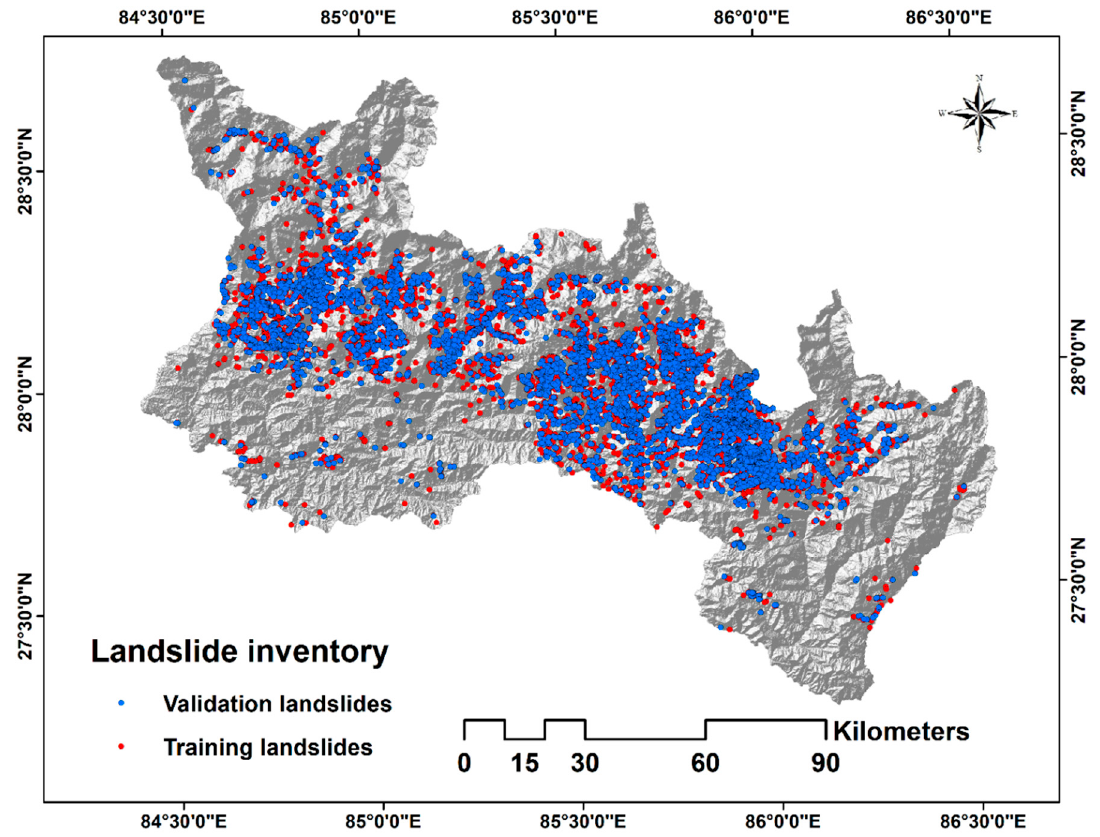
Figure 2. Landslide inventory map of the study area with the distribution of training and validation datasets.